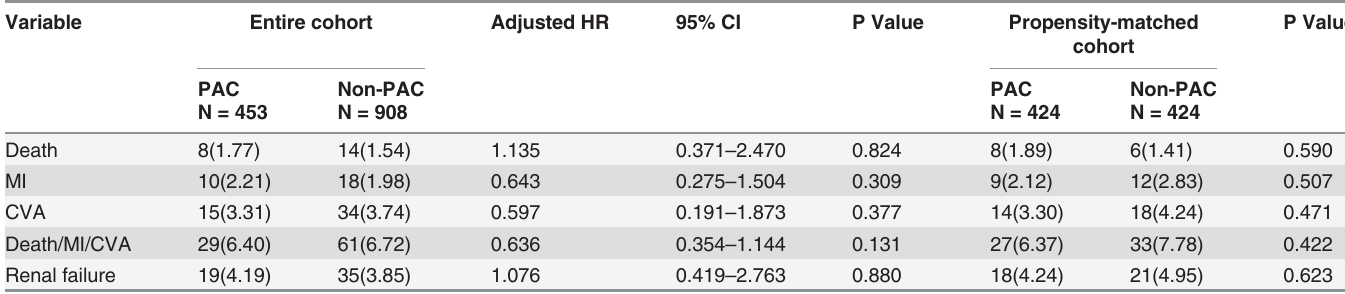
Table 3. Long-term